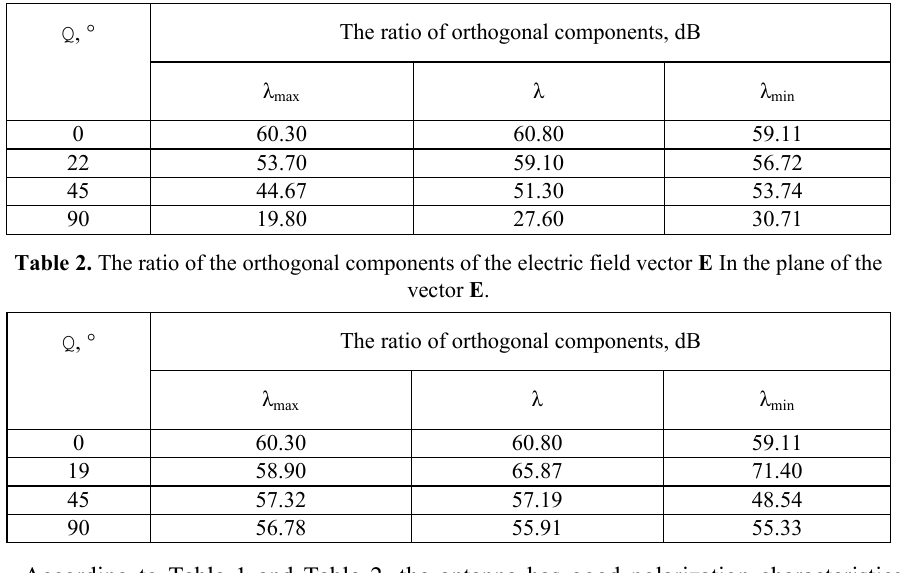
Table 1. The ratio of the orthogonal components of the electric field vector Е in the plane of the vector Н .